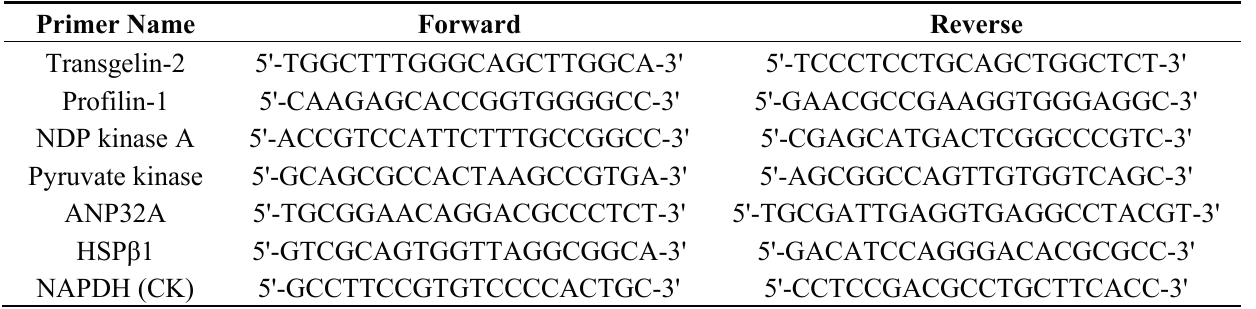
Table 3. Primers used in qPCR for verifying the identified proteins